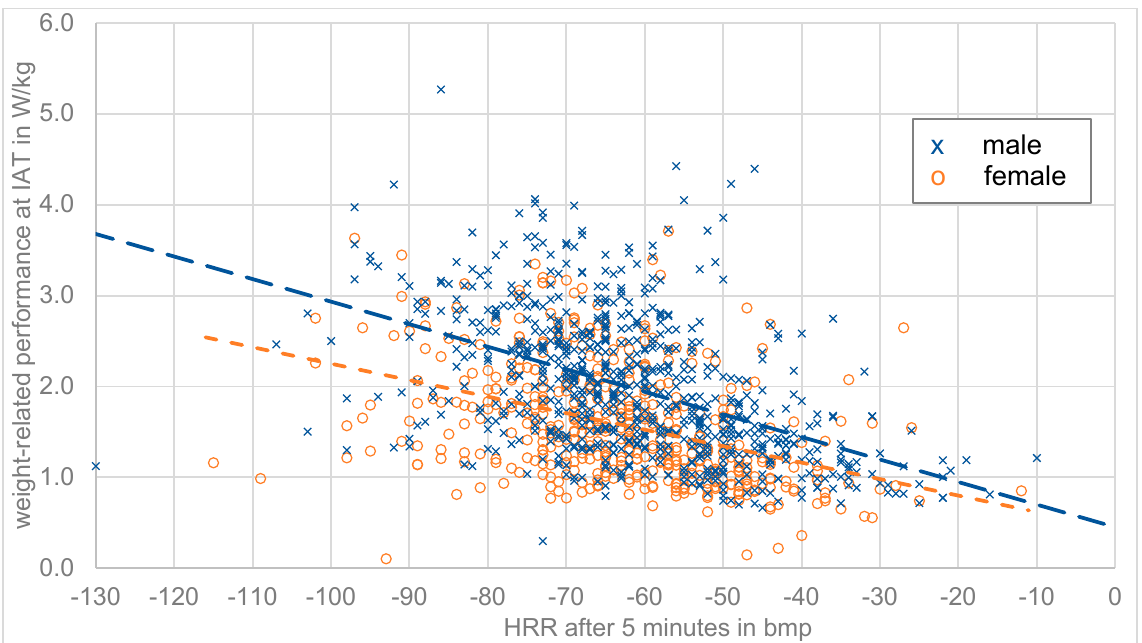
Figure 2. Weight-related performance depending on HRR after 5 min for all 1234 athletes in our dataset.